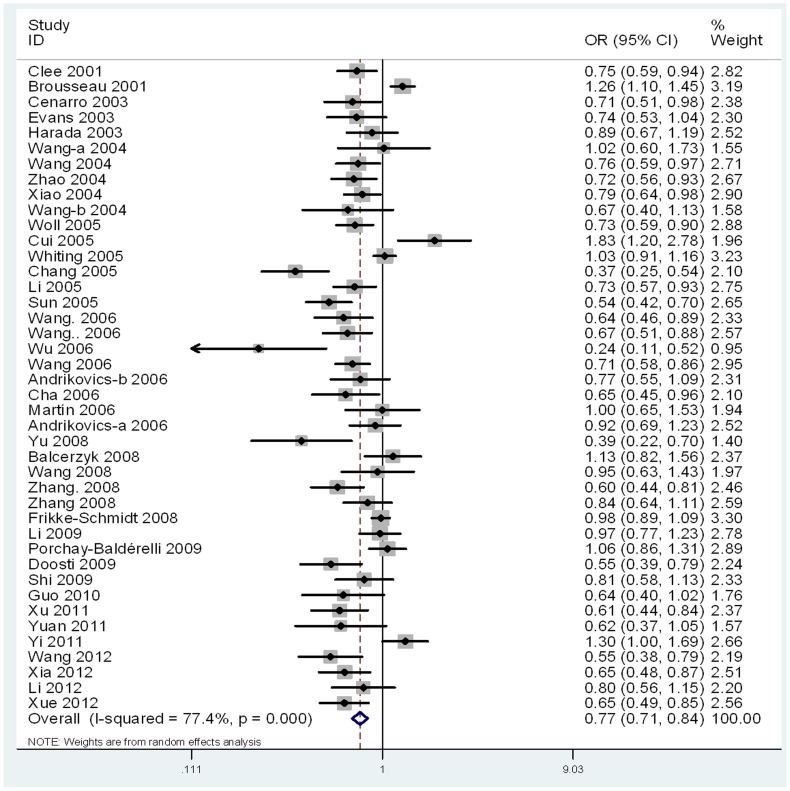
Forest plot for ABCA1 R219K polymorphism and AS risk in the allelic model (K allele vs. R allele).